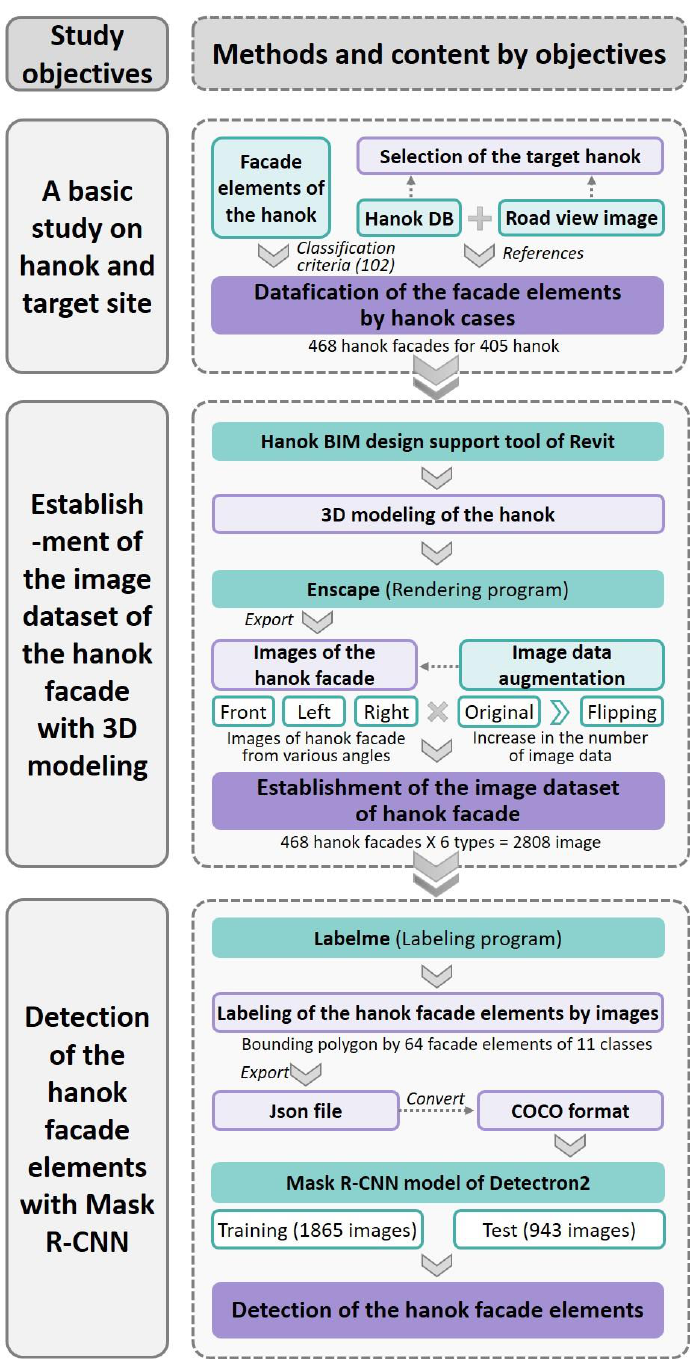
Figure 2. Flowchart of research.